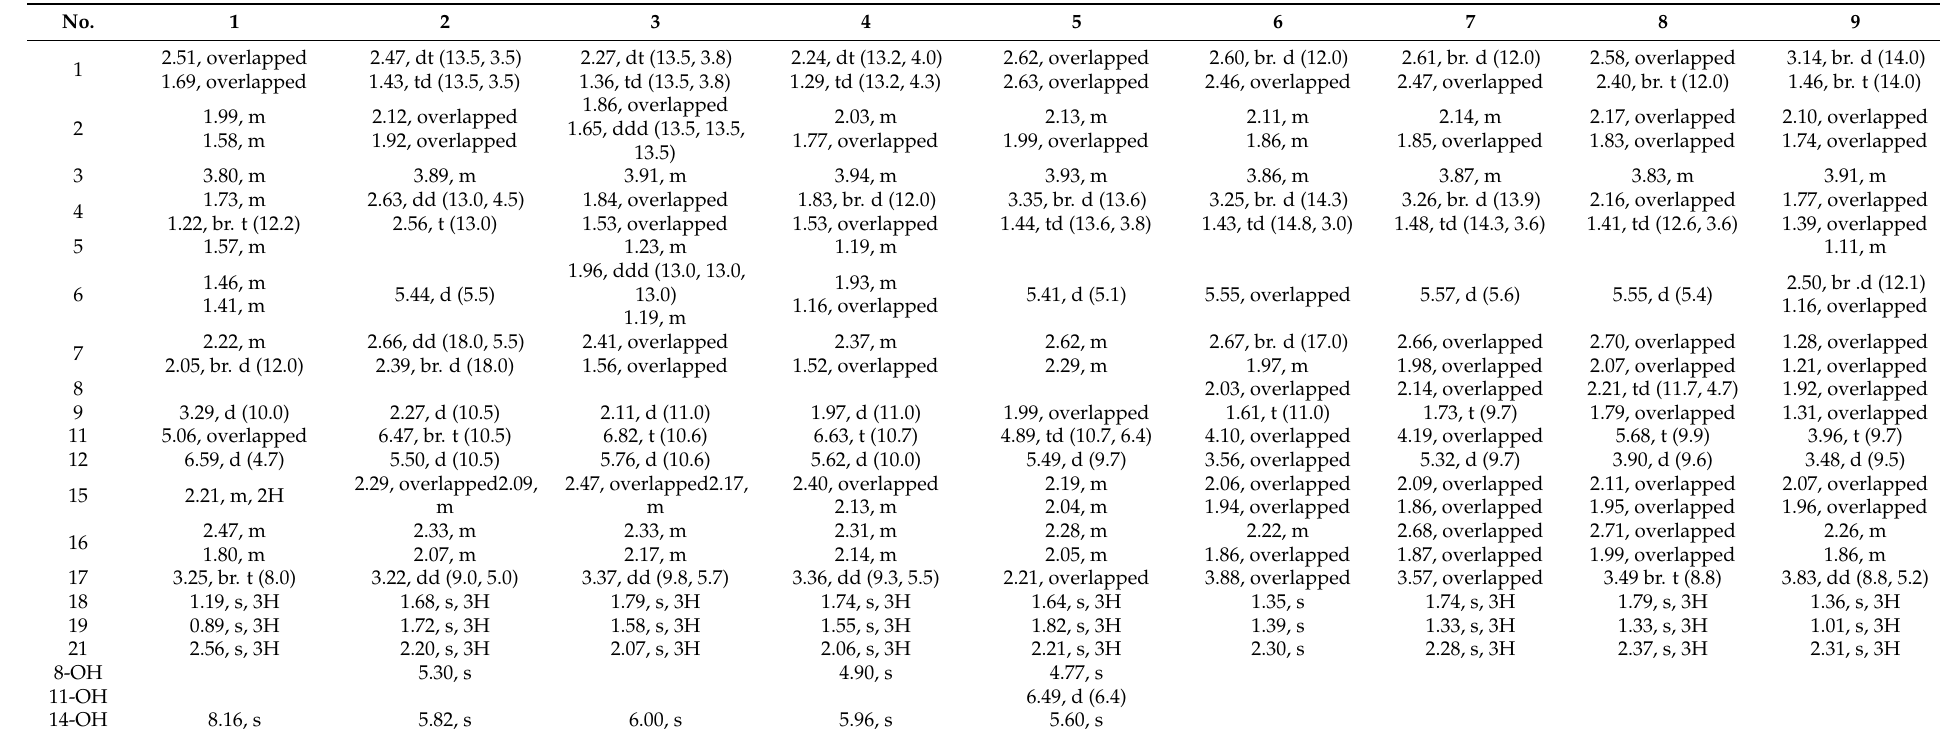
Table 1. 1 H NMR Spectroscopic Data of the Aglycones of Compounds 1 – 9 in Pyridine- d 5 (600 MHz, J in Hz).